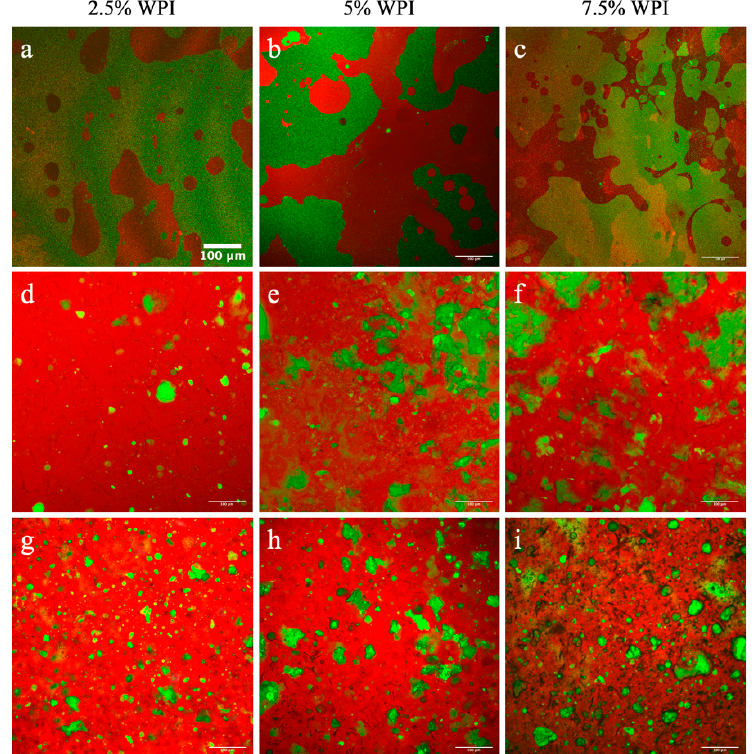
Figure 7. Confocal microscopy images of: ( a – c ) CD samples, ( d – f ) OC samples gelled with 1% RBW, and ( g – i ) OC samples gelled with 10% RBW. The lipid component is shown in red and the protein network is displayed in green.